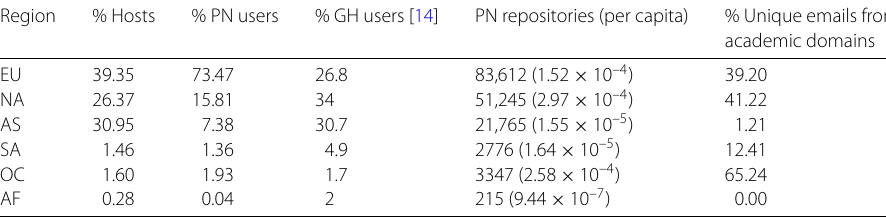
academic domains